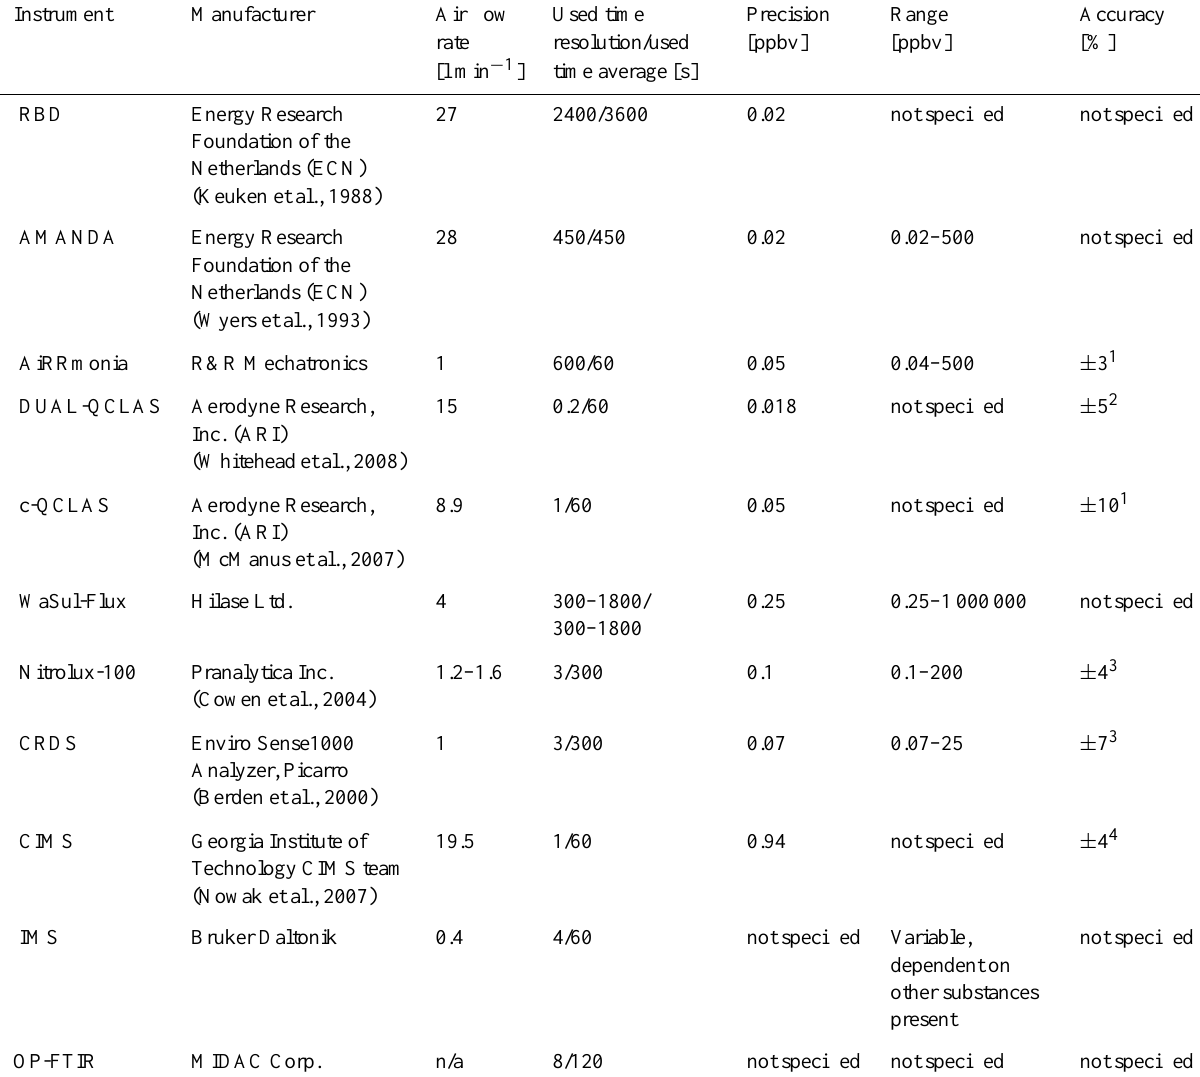
Table 1. Summary of the characteristics of the